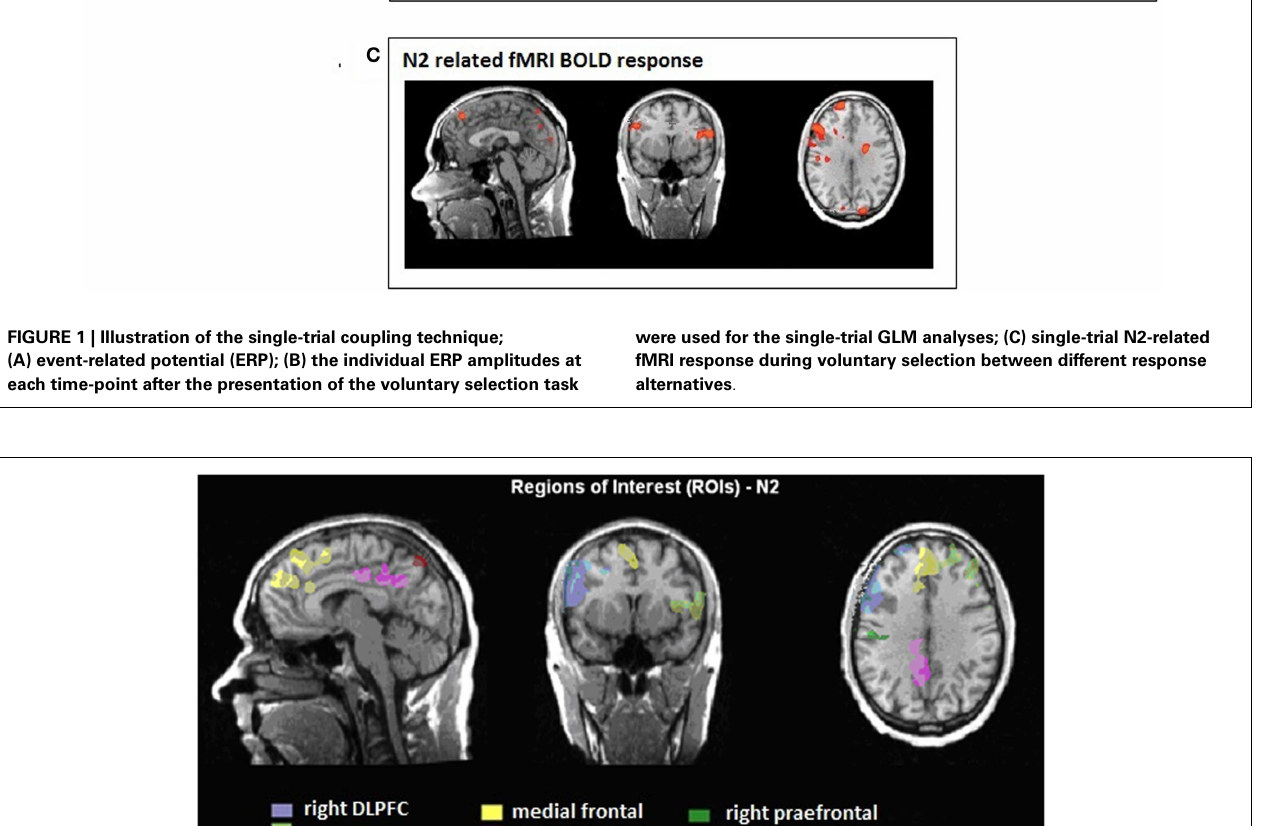
FIGURE 2 | Illustration of the regions of interest (ROIs) presented on talairachised anatomical image .The ROIs are based on the BOLD activity, which is correlated to the N2 amplitudes during voluntary selection of healthy subjects.